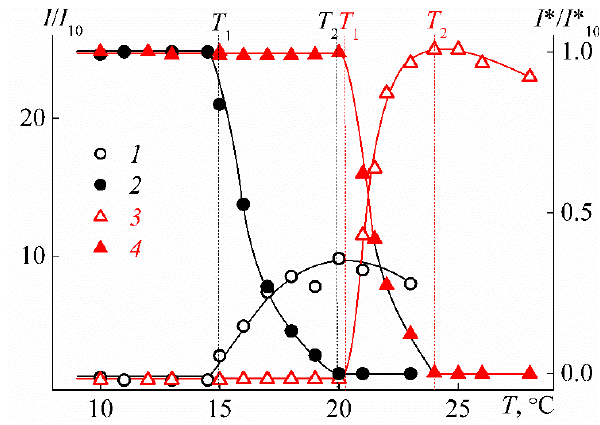
Figure 12. Dependencies of the relative values of light scattering intensity I / I 10 (1, 3) and optical transmission I * / I * 10 (2, 4) on temperature T for solutions with concentration c = 0.0280 g cm − 3 of PEI-1 (1, 2) and PEI-2 (3, 4). I 10 and I * 10 are light scattering intensity and optical transmission at 10 ◦ C, respectively.